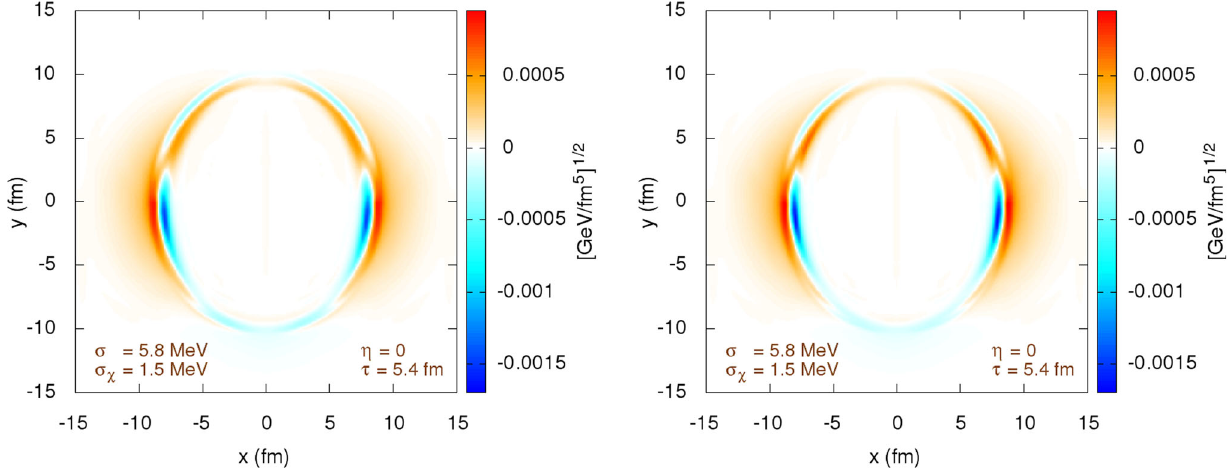
Fig. 10 Electric charge density distribution in the fluid comoving frame from magnetic fields of both classical and chiral origin in the transverse plane at mid-rapidity. Left: Maxwell equations charge determination method. Right: Vorticity method. Here σ = 5 . 8MeV and σ χ = 1 .